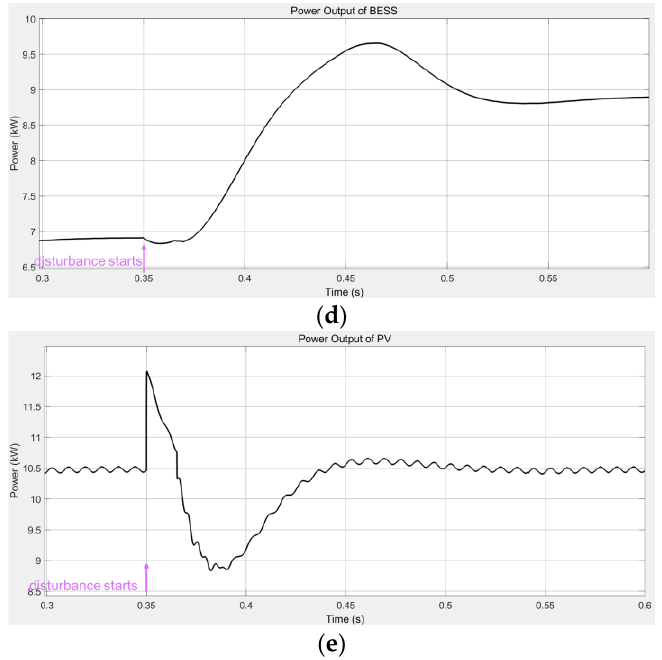
Figure 13. Performance when a DC-side surplus load happens. ( a ) Signals at Bus 6; ( b ) Signals at AC/DC interfacing Bus 8.; ( c ) Signals at DC bus; ( d ) Power output of the BESS; ( e ) Power output of the PV generation.